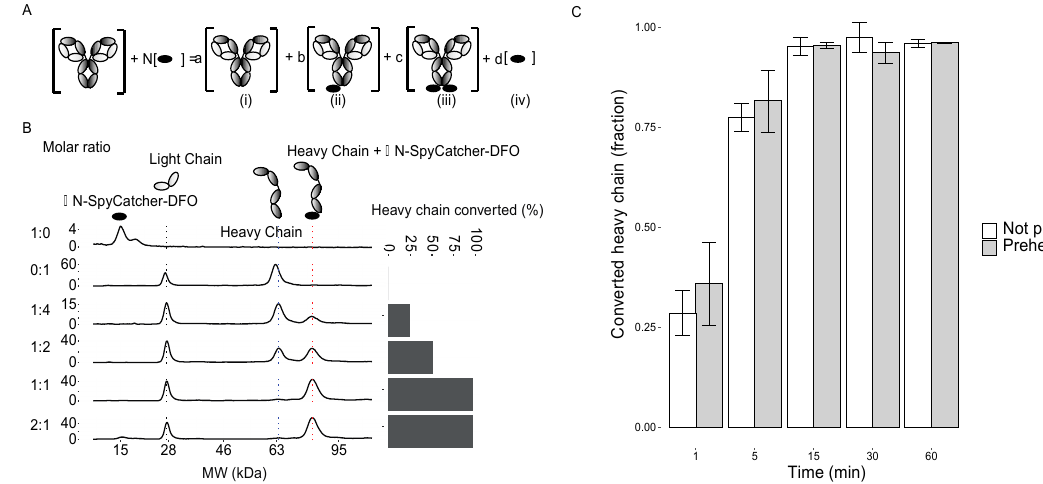
Figure 2. Evaluation of the bioconjugation reaction. ( A ) Overview of the reaction of IgG-SpyTag with DFO-SpyCatcher. IgG reacted with SpyCatcher can result in four products: (i) an unlabeled IgG, (ii) an IgG with one SpyCatcher, (iii) an IgG with two SpyCatchers, and (iii) unreacted SpyCatcher. ( B ) Analysis of the reaction products at different molar ratios of SpyTag: SpyCatcher. After reaction, the sample is reduced, separating the IgG into light and heavy chains. A heavy chain modified with the SpyCatcher results in an increase in MW. Representative bioanalyzer chromatograms are shown for the reactions, and the quantification of peaks is shown on the right. ( C ) The kinetics of SpyCatcher-DFO with IgG-SpyTag were measured by pre-incubating the ∆ N-SpyCatcher-DFO for 1 h at RT or being heated. All the reactions include IgG-SpyTag (10 μ M) for the indicated times.